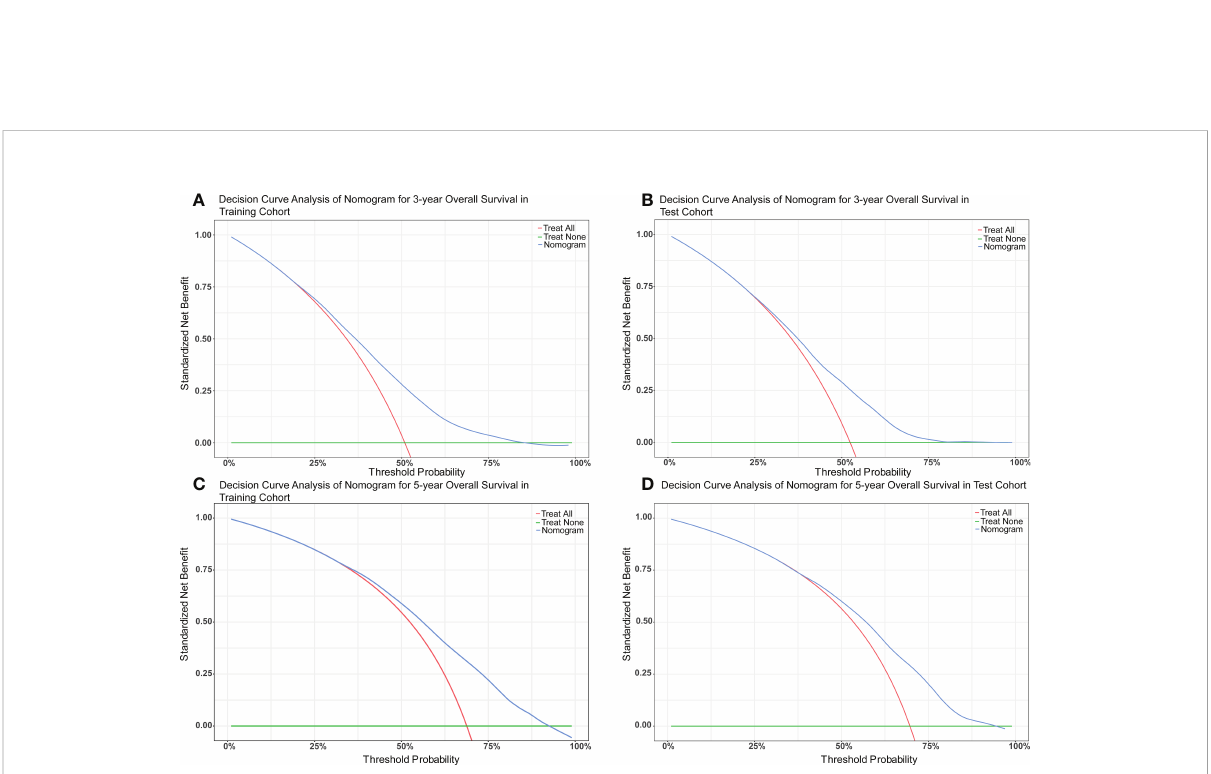
FIGURE 9 (A) DCA of nomogram for 3-year OS in the training cohort. (B) DCA of nomogram for 3-year OS in the test cohort. (C) DCA of nomogram for 5-year OS in the training cohort. (D) DCA of nomogram for 5-year OS in the test